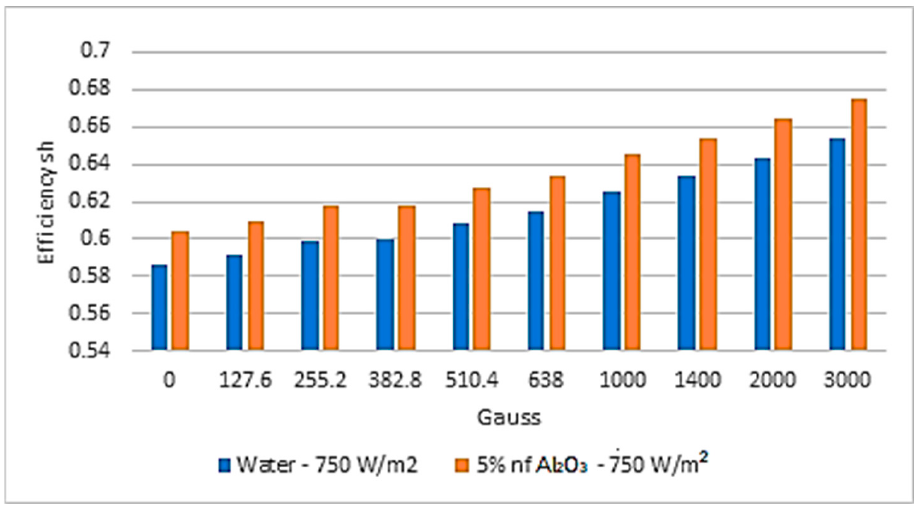
Figure 10. Thermal efficiency of hybrid system with PV-Th solar panels with different magnetic fields.